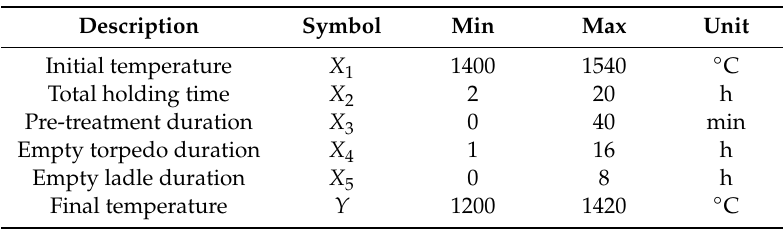
Figure 1. Hot metal process from blast furnace (BF) to basic-lined oxygen furnace (BOF) in which the following phases are considered: BF tapping, pre-treatment, transport, and transfer to BOF shop. To predict the final hot metal temperature, Y , five relevant variables are used as model inputs: Initial temperature X 1 , total elapsed time X 2 , pre-treatment duration X 3 , empty torpedo duration X 4 , empty ladle duration X 5 . Table 1. Model variables.